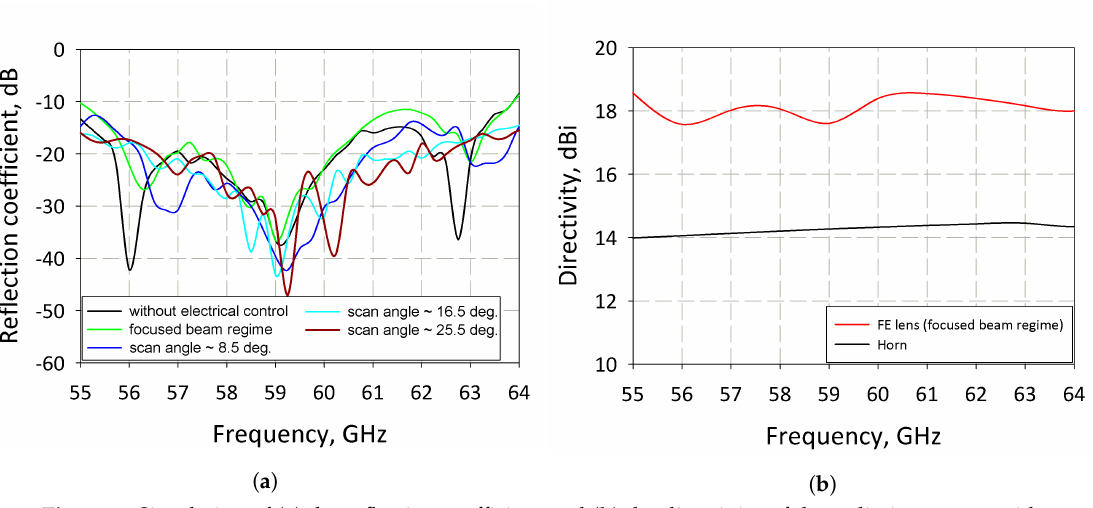
Figure 9. Simulation of ( a ) the reflection coefficient and ( b ) the directivity of the radiation source with and without the FE